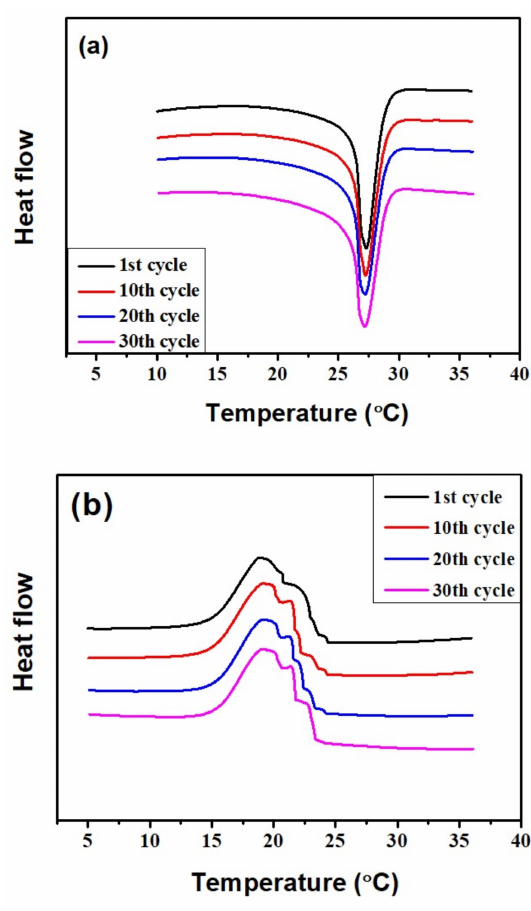
Figure 11. DSC thermograms of PCM-filled MEMS after undergoing 1, 10, 20, and 30 heating/cooling cycles during the ( a ) melting and ( b ) freezing